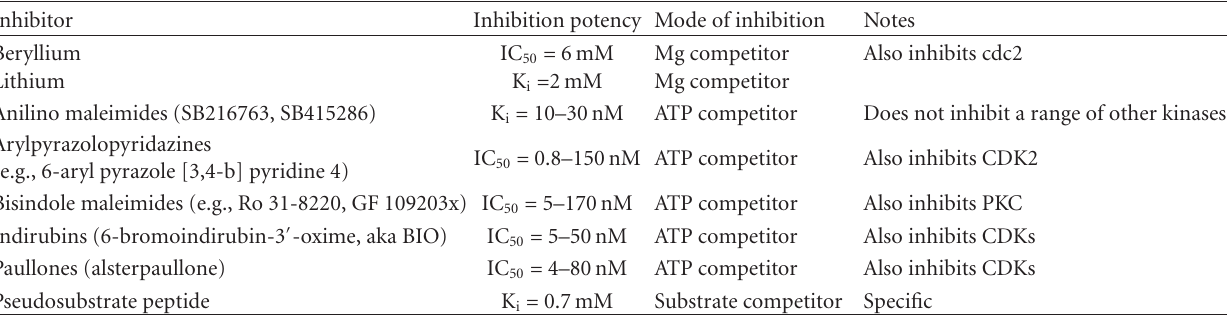
Table 4: Selected list of known GSK-3 β